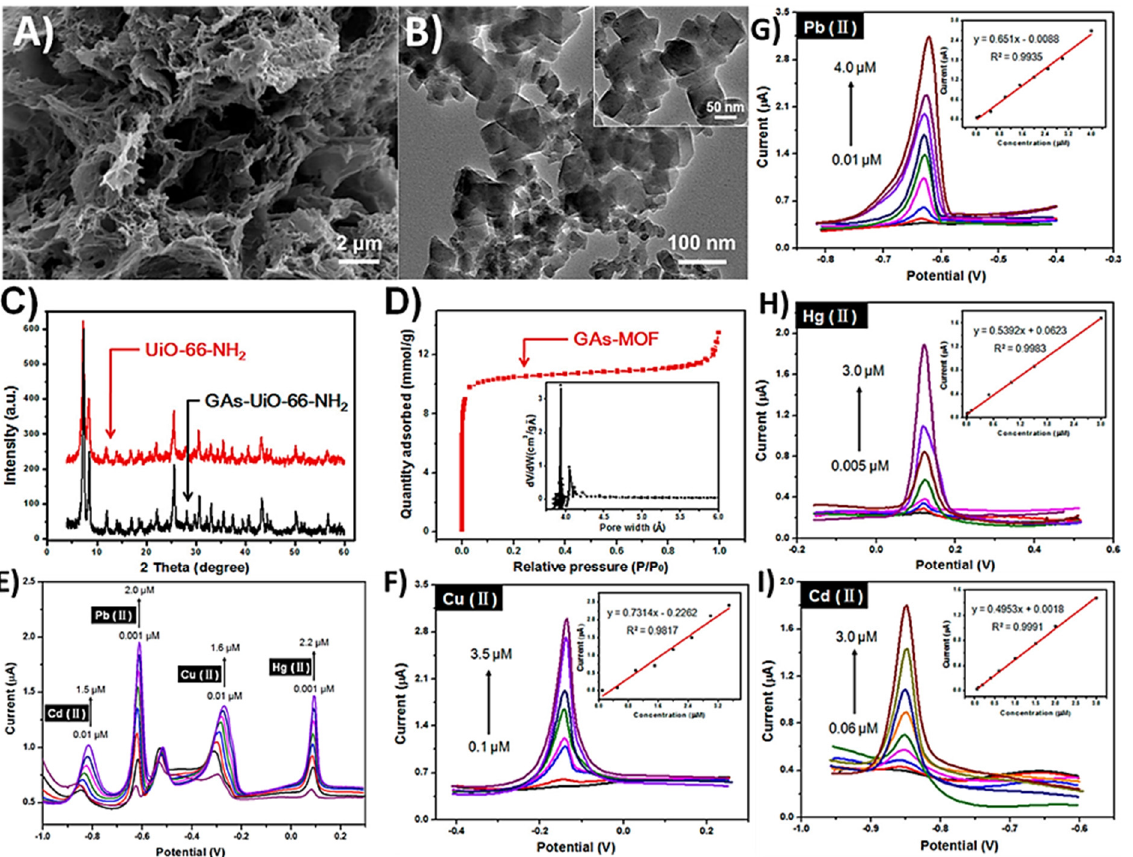
Figure 22. SEM image of ( A ) GAs, TEM image of ( B ) UiO-66-NH 2 , ( C ) XRD spectra, ( D ) N 2 adsorption-desorption isotherm of the GAs-UiO-66-NH 2 , ( E ) DPSV response of the GAs-UiO-66-NH 2 altered GCE after adding diverse concentrations of Cd 2+ , Pb 2+ , Cu 2+ , and Hg 2+ in acetate buffer solution (0.2 M, pH 5.0, DPSV response of the GA-UiO-66-NH 2 altered GCE for specific analysis of ( I ) Cd 2+ , ( F ) Cu 2+ , ( G ) Pb 2+ , and ( H ) Hg 2+ over a concentration range of 0.06 − 3.0 µ M, 0.01 − 4.0 µ M, 0.1 − 3.5 µM, and 0.005 − 3.0 µM, respectively. Reproduced with the permission from [198].